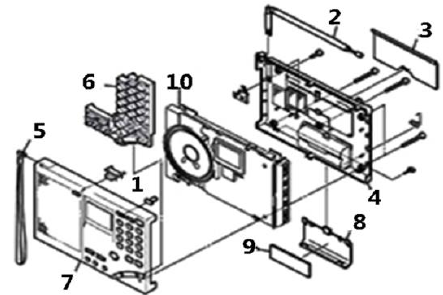
Figure A4. Schematic diagram of a radio set [4].